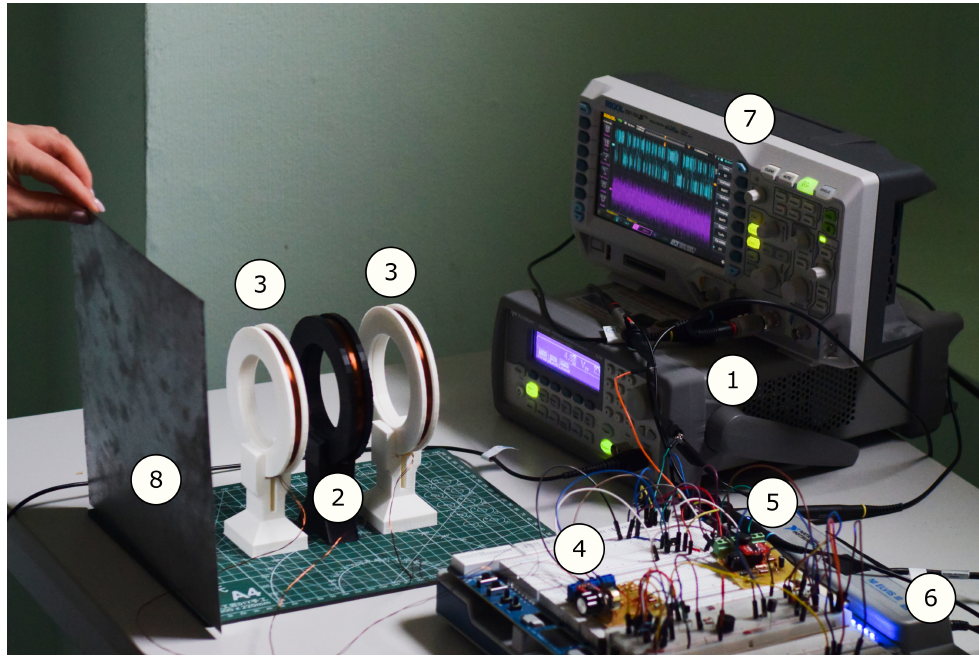
Figure 9. Experimental setup. Here: (1) digital sine wave generator Keysight 33210A, driving the transmitter coil (2); (3) receiving coils; (4) differential amplifier; (5) chaotic circuit implementing the Duffing oscillator; (6) NI ELVIS III power supply and digital data acquisition station; (7) oscilloscope Rigol DS1054Z displaying diff-amp out (violet wave) and the Duffing oscillator out (blue wave); (8) metal plate used as a target. The Duffing oscillator is in a chaotic mode. The coil diameter is 10